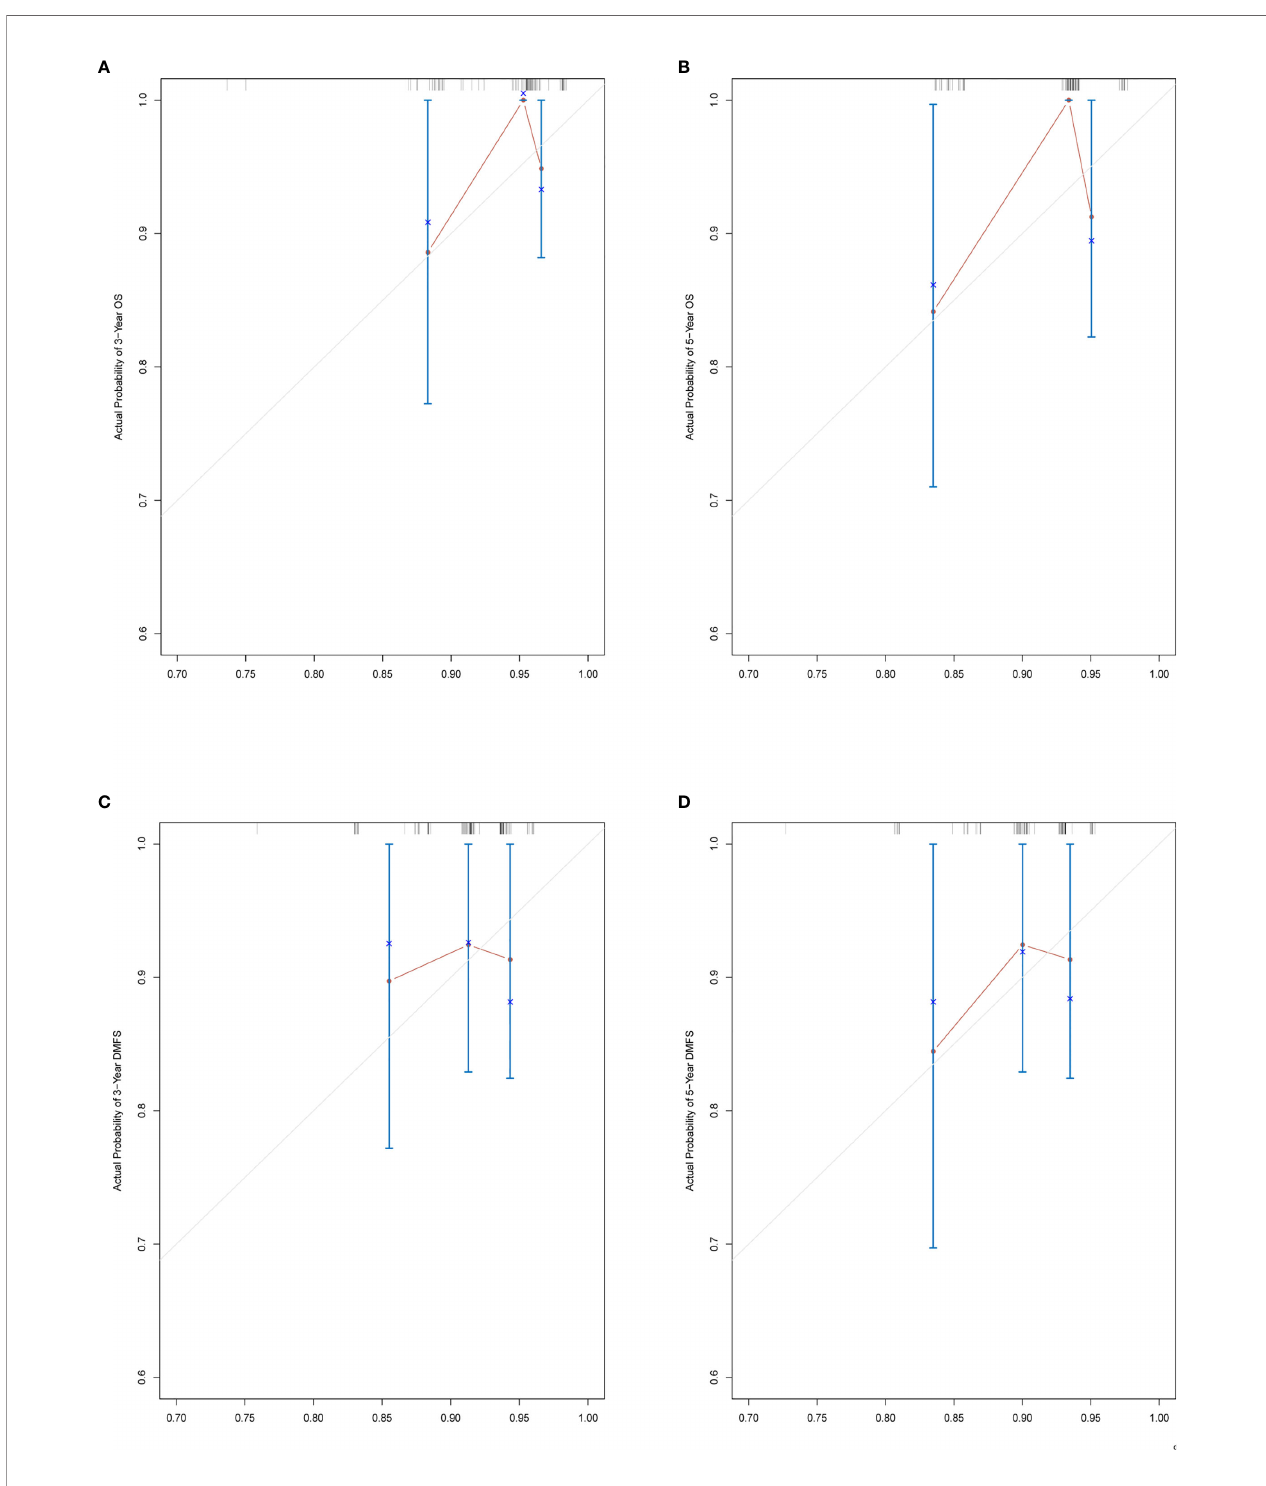
FIGURE 6 | Nomogram model calibration curves of 3-year (A) and 5-year (B) overall survival, and 3-year (C) and 5-year (D) distant metastasis-free survival in the validation